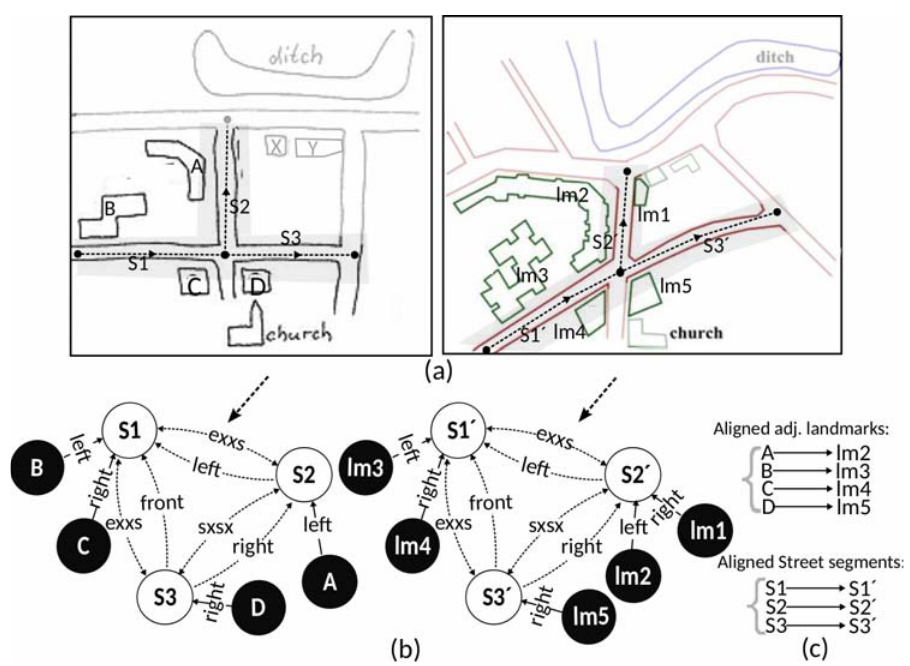
Figure 12: (a) Street segments and landmarks in the sketch and geo-referenced maps, (b) the employed constraints using multiple aspects, and (c) diagram representing alignments of street segments with the help of the aligned adjacent